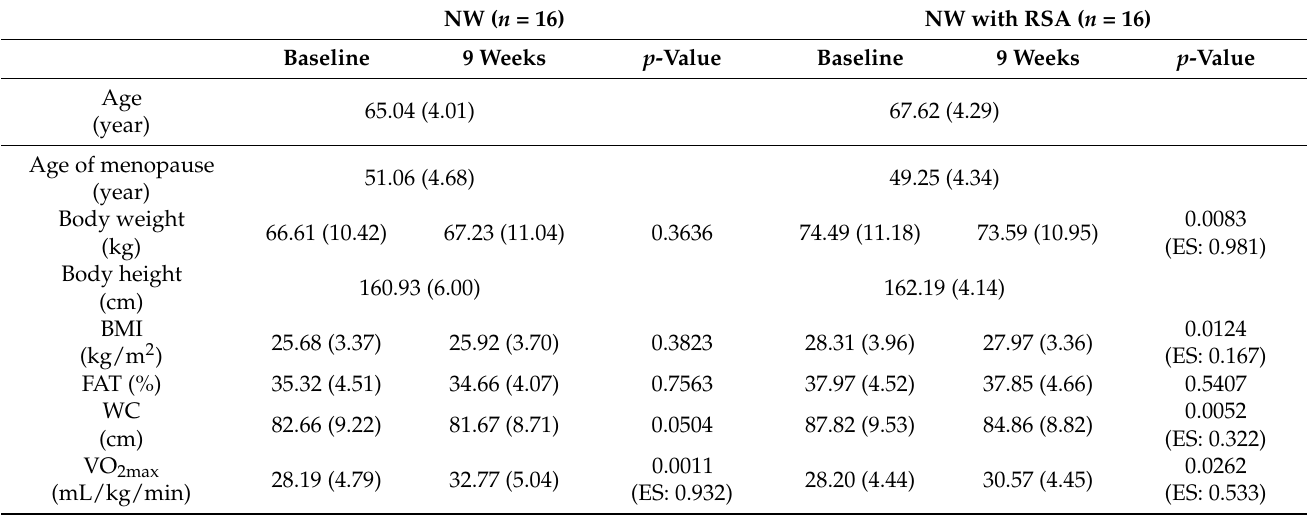
Table 1. The anthropometric characteristics and maximal oxygen uptake of the groups subjected to the